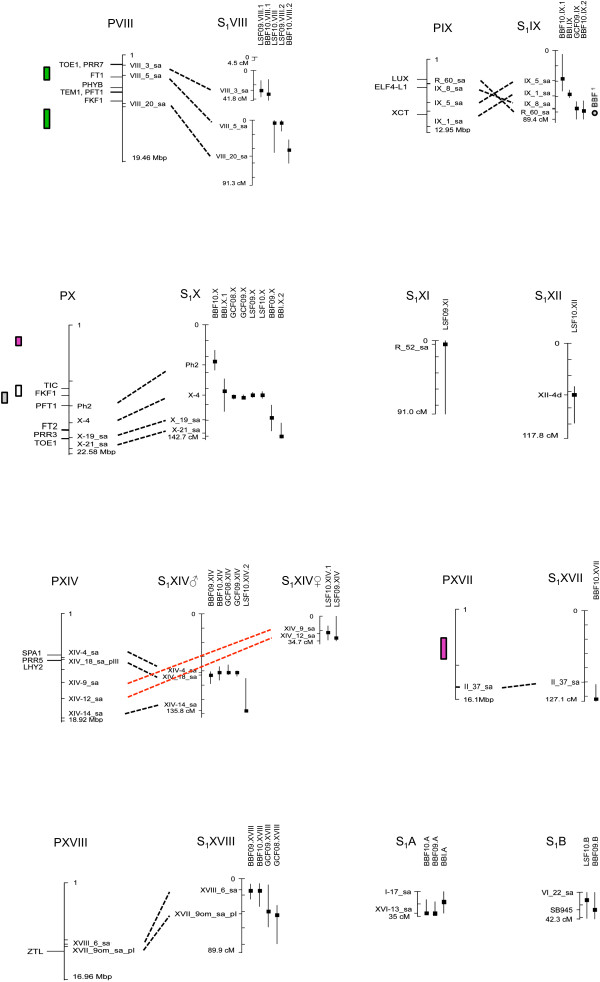
Location of spring and autumn phenology QTLs on the consensus genetic linkage map from the S1 pedigree on LG VIII to XIX. The peak position of the local LOD (P in Table 4) is marked as a squared symbol and a support interval of 1.5-unit drop off on either side of the LOD peak is reported for each QTL. QTLs are named as in Table 4. Candidate genes and their position in the corresponding Populus chromosome are indicated. Grey circle on LG IX: Bud burst QTLs in field (BBF) conditions from [42] (same mapping pedigree, tentative positions based on common AFLPs). QTLs for phenology traits in Populus (taken from literature) are indicated. Red boxes: Selected QTLs associated with bud set (several stages and sub-processes) in Populus nigra from Table six in [50]. White boxes & Grey boxes: Bud set or bud flush QTLs from [48] at tentative positions, based on their distance from phenology candidate genes (Chr X) in the original publication (as in [18]) Green boxes: Bud set robust quantitative trait loci (QTL) regions in [18].